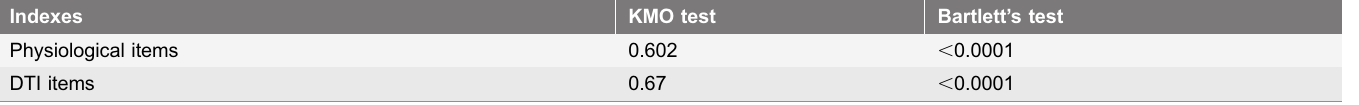
Table 5. Factor analysis of physiological and DTI